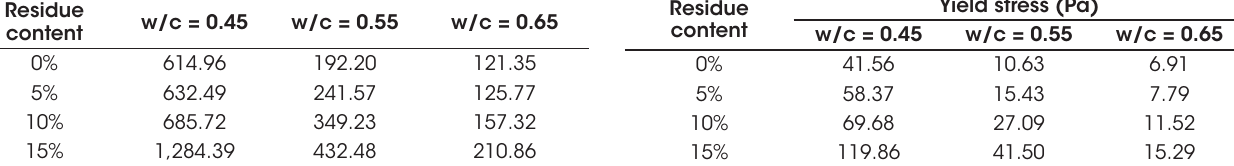
Values of the hysteresis area of the flow test Residue content